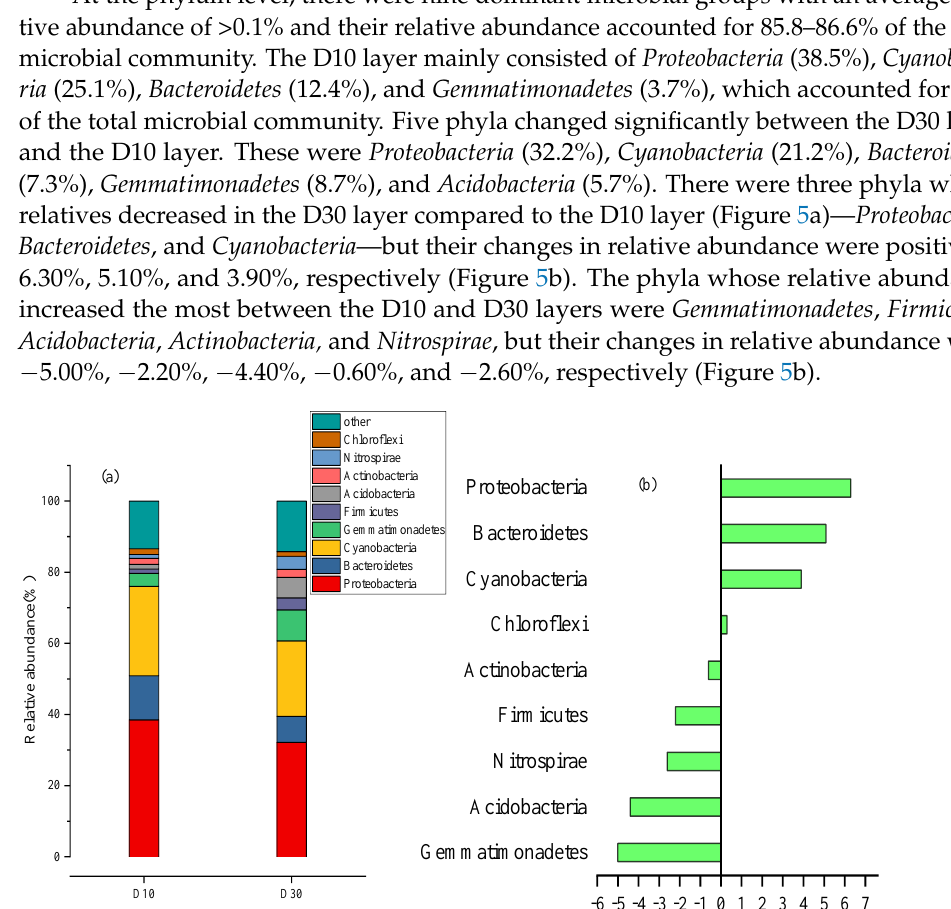
Figure 6. Soil microorganism changes in the wetland sediments at the genus level. ( a ) Soil bacterial community structure at genus level; ( b ) changes in relative abundance. 2.3.2. Microbial Community Structure at the Wetland Electrode As shown in Figure 7, at the wetland electrode, there were nine dominant microbial groups with an average relative abundance of >1% at the phylum level, and their relative abundance accounted for 75.0 – 77.9% of the total microbial community. At the electrodes, Proteobacteria (34.5%), Cyanobacteria (19.0%), Bacteroidetes (6.3%), and Gemmatimonadetes (5.7%) were the main groups present, and these groups accounted for 77.1% of the total microbial community. As shown in Figure 8, at the wetland electrode, the groups with an average relative abundance of >0.1% at the genus level were classified as the dominant genera. The domi- nant genera groups were Nitrospira (2.4%), Rhodobacter (1.50%), Sphingomonas (4.30%), Ta- brizicola (1.25%), Nevskia (0.76%), and Devosia (1.13%). An analysis and comparison of the microbial community structure at the phylum level and genus level in the D10 and D30 layers of the wetland sediment soil showed that Proteobacteria and Bacteroidetes became more dominant at the phylum level, and the dom- inant microorganisms accounted for 85.8 – 86.6% of the total microbial community. At the